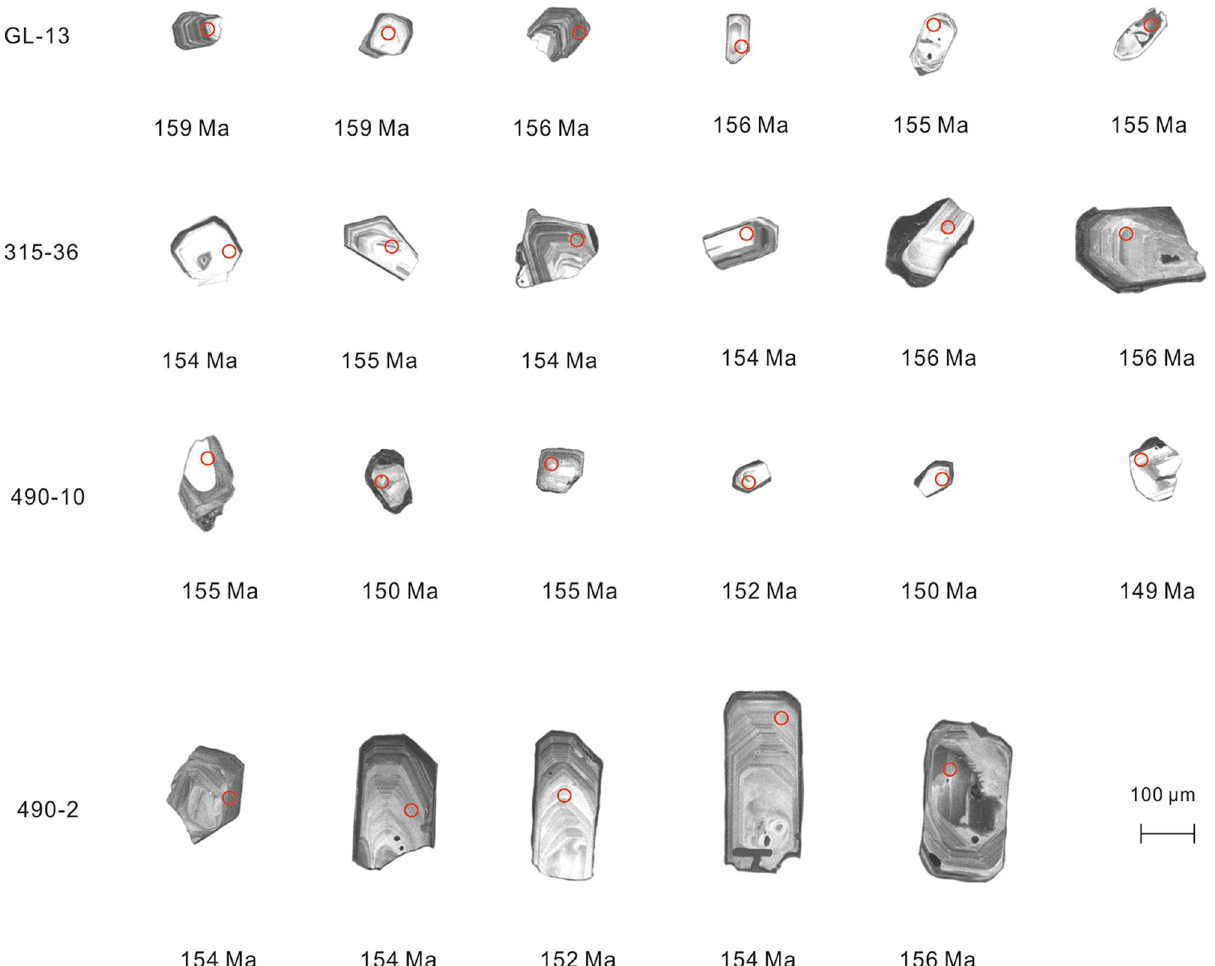
Figure 5. Cathodoluminescence images of zircons with corresponding 206 Pb/ 238 U ages for the samples from the